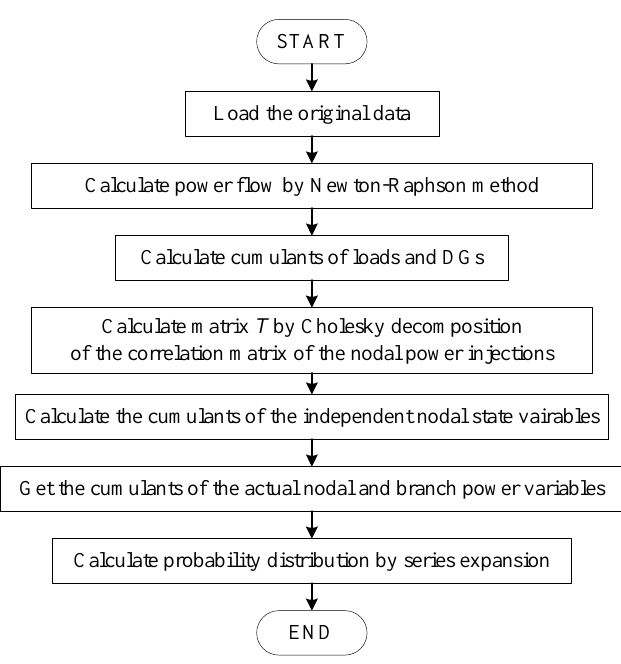
Figure 2. Flowchart of novel PLF algorithm considering nodal correlations.